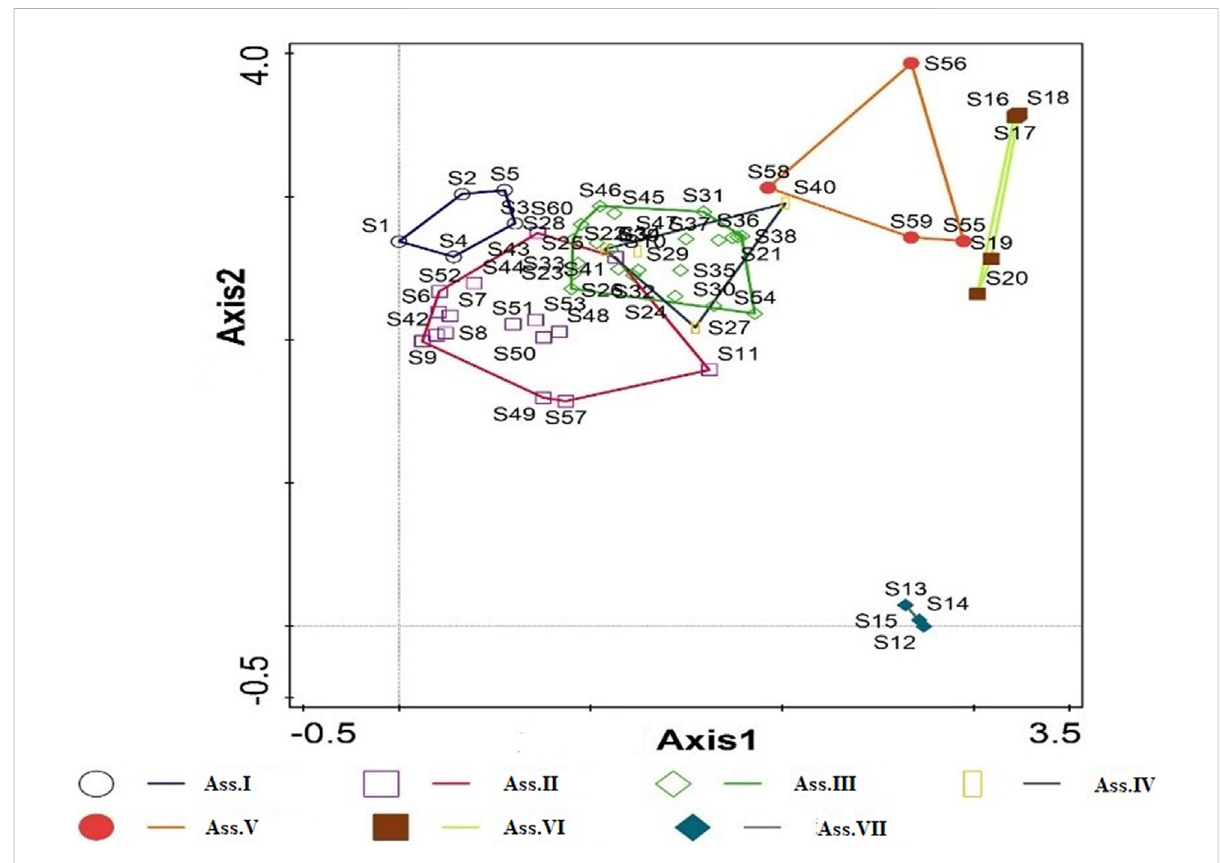
FIGURE 4 DCA two-dimensional ordination diagram for samples of sandy alpine grassland community.